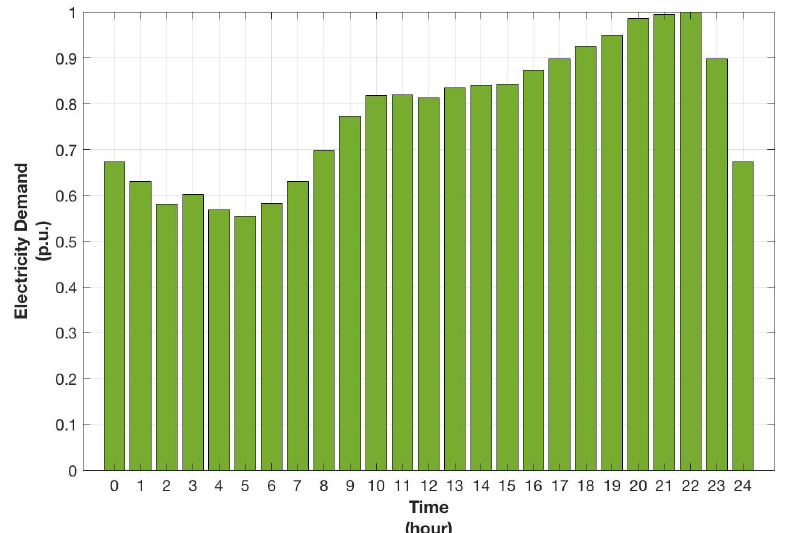
Figure 1. Normalized load profile for an Italian household